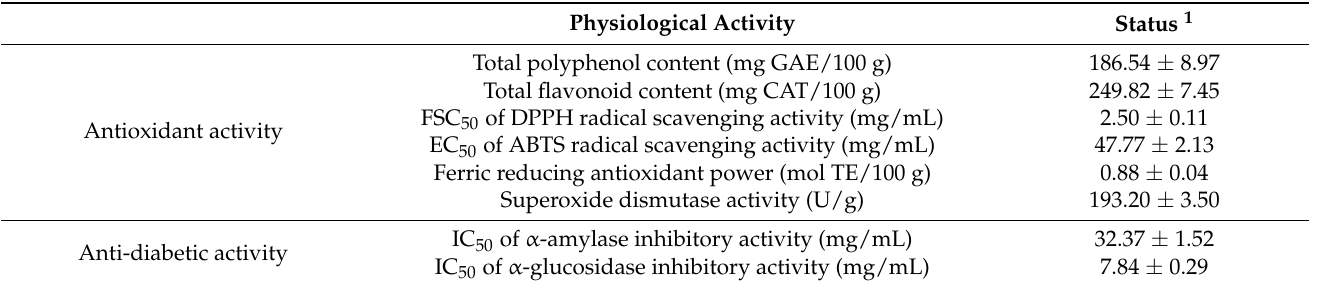
Table 2. Antioxidant and anti-diabetic activity of Kaniwa. Physiological